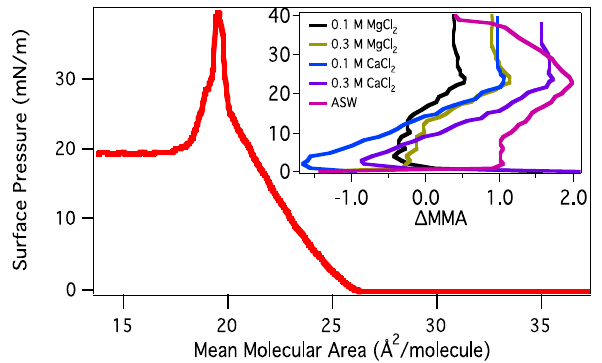
Figure 2. π -A isotherm of palmitic acid (PA) monolayer on water. Inset shows isotherms of PA on various salt subphases relative to the isotherm on